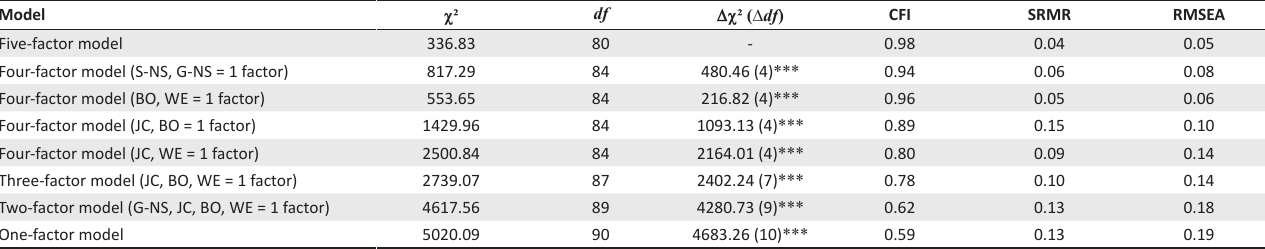
TABLE 3: Confirmatory factor analysis fit indices for measurement model ( N = 1500).